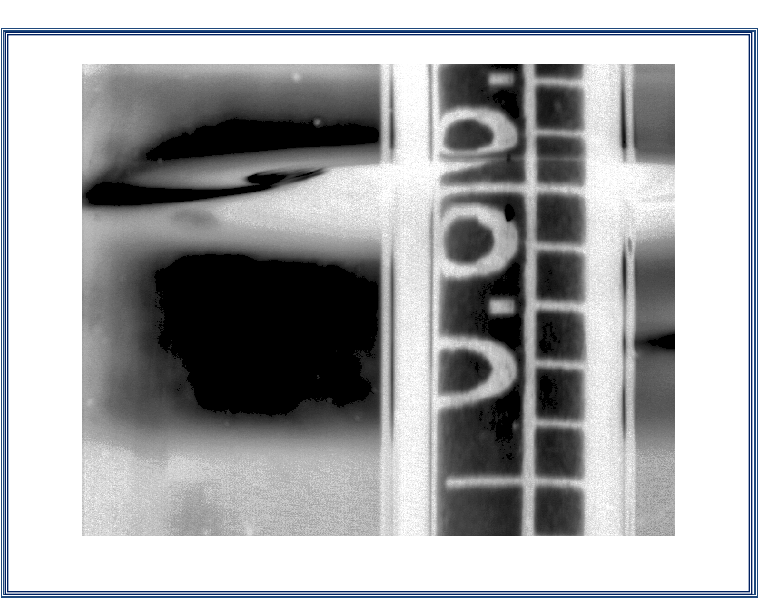
Figure 13. Negative image.